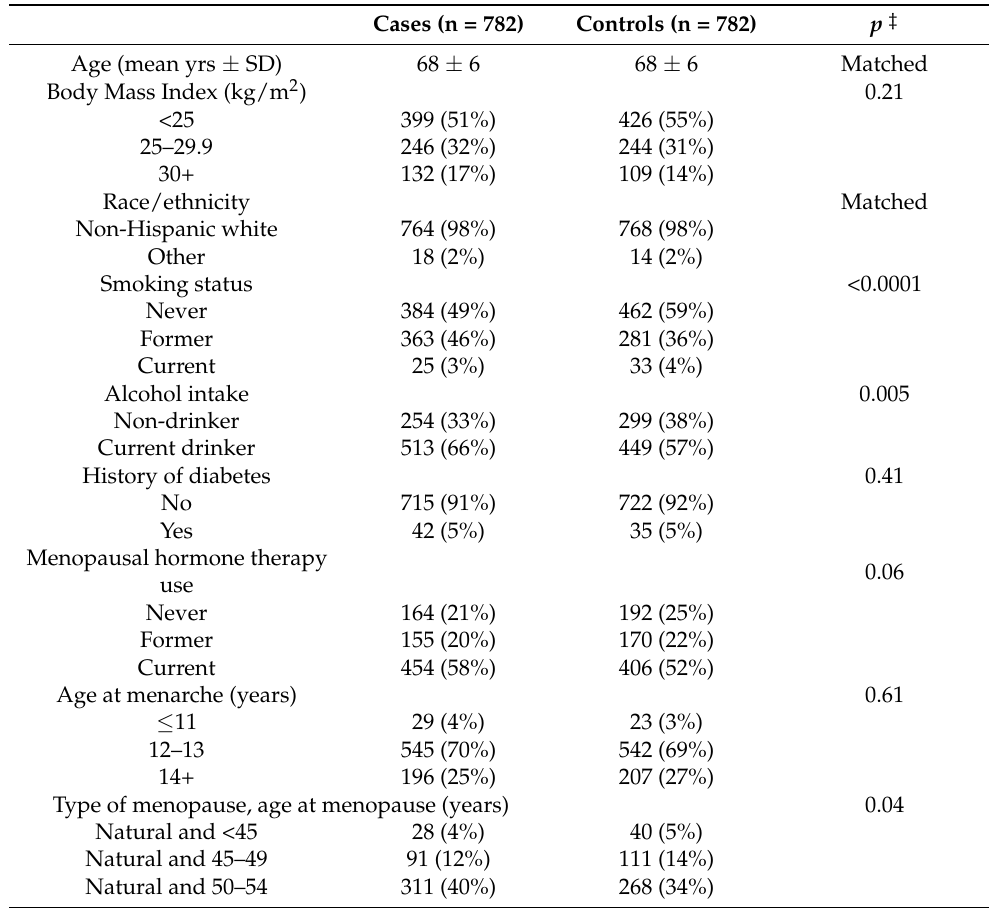
Table 1. Participant characteristics at blood draw in a nested case-control study in the Cancer Prevention Study-II * ,† . Cases (n =